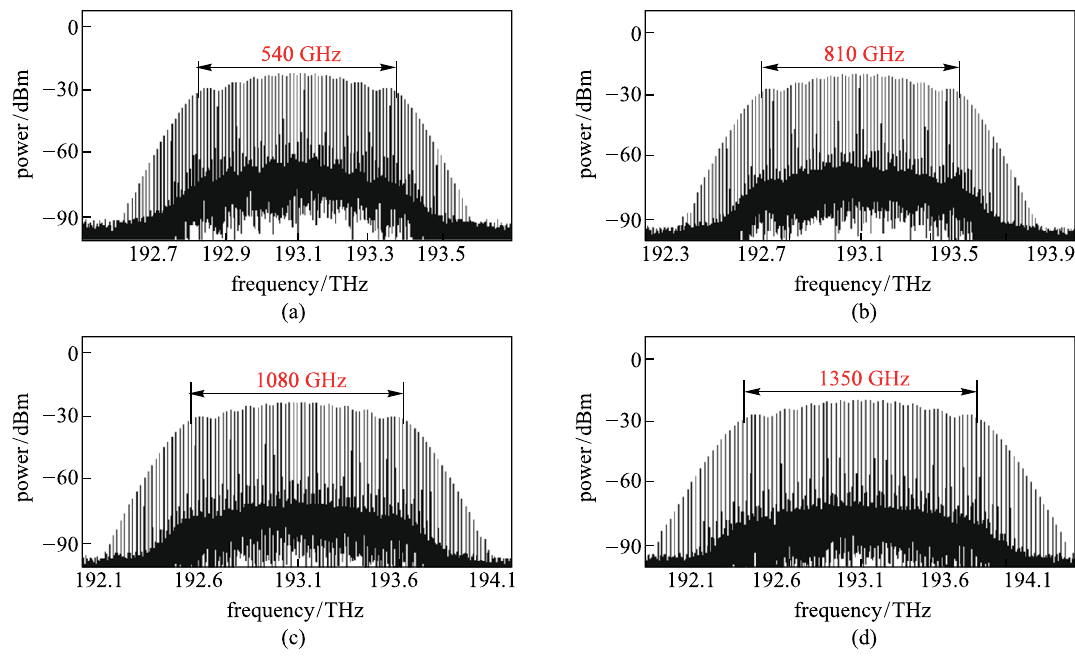
Fig. 3 Influence of the frequencies of the RF source signal on the optical spectrum of the OFC. a 5 GHz, b 7.5 GHz, c 10 GHz, d 12.5 GHz